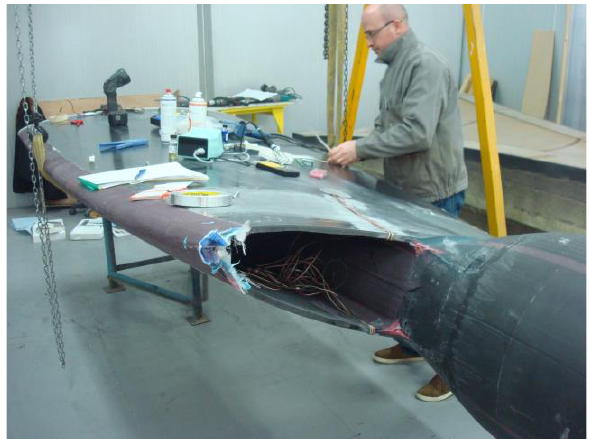
Fig. 8. Strain gauge instrumentation of Sabella D10 tidal turbine blade. Installation of strain gages on